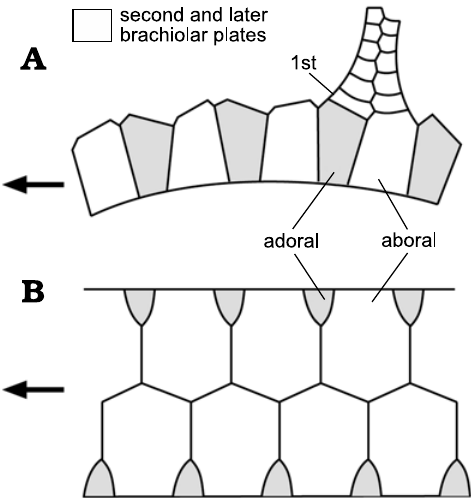
Fig. 8. Structure of the ambulacra and brachioles in the callocystitid Pseudo crinites bifasciatus Pearce, 1843 (SM A.10192), Wenlock (Silu- rian), Dudley, UK. First plate (1st) in a brachiole lies directly above the adoral floor plates (grey). This suggests floor plates are the first pair of brachiolar plates modified to form the ambulacral axis. Second and subse- quent brachiolar plates white. In callocystitids, floor plates are developed on the thecal surface. A . Side view showing the high profile of the ambu- lacral axis and rapidly tapering brachiole. B . Impressions of ambulacral floor plates on the thecal plates. Arrows point to the mouth. Redrawn and relabelled from Paul 1967a: 326, figs. 17, 18.